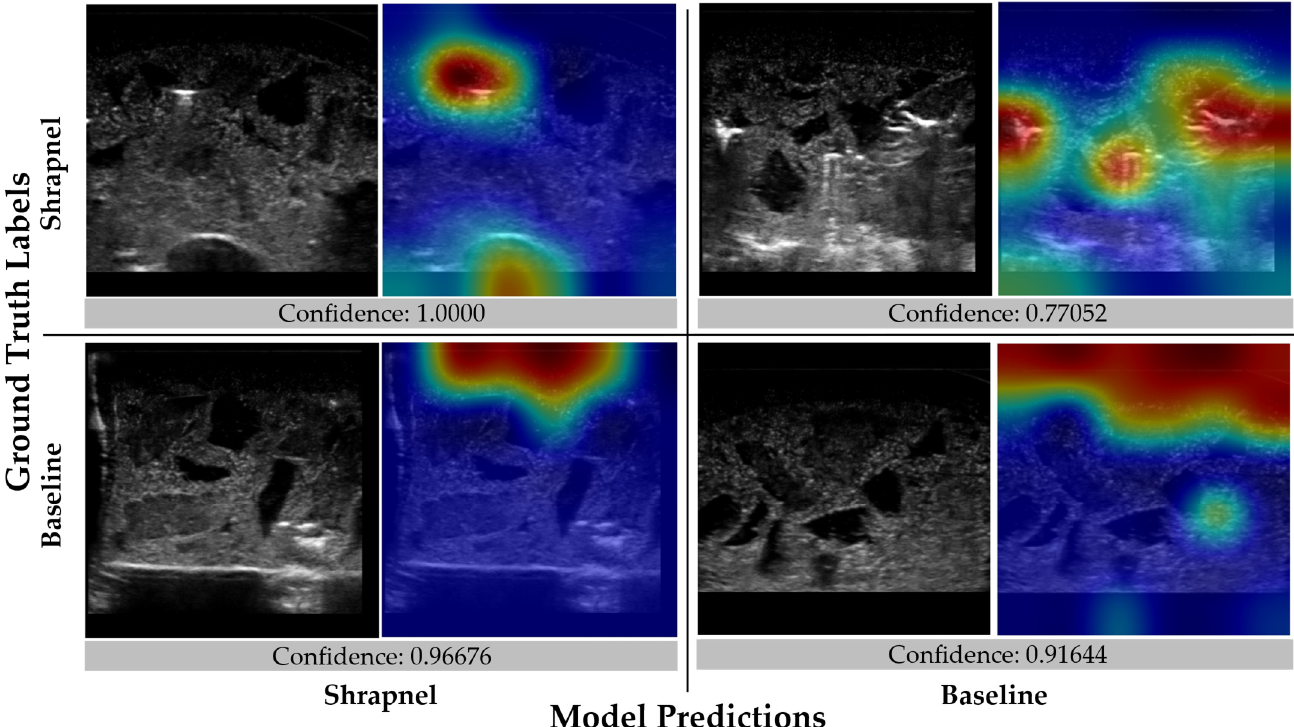
Figure 3. Performance of ShrapML model with blind subject testing. ( A ) Average confusion matrix results across three training replicates for 70 shrapnel and 70 baseline images for a blind test subject. ( B ) Receiver operating characteristic curves and ( C ) summary of performance metrics for three rep- licate training runs. Results are shown as averages and standard deviations across three replicate trained models.